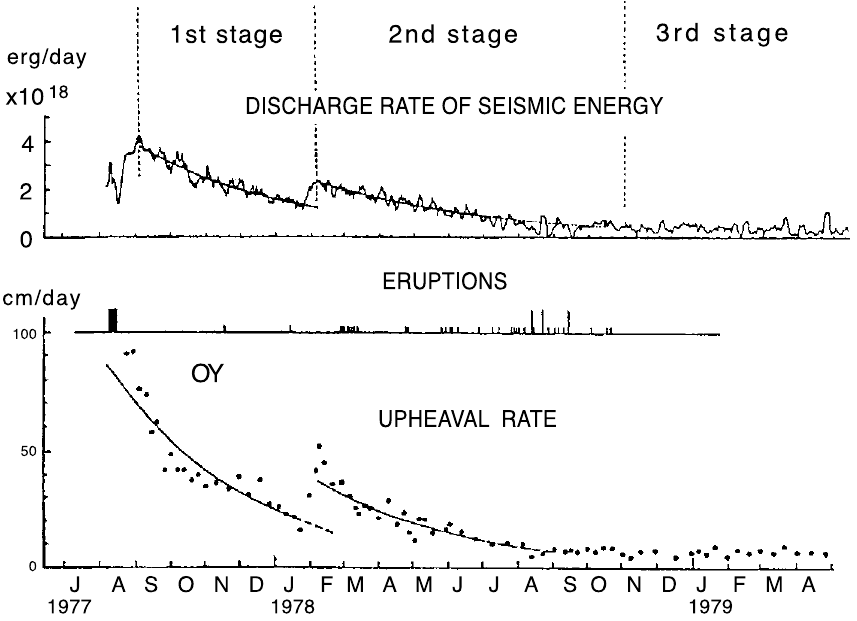
Fig. 4. Seismicity and deformation in the 1977 eruption of Usu volcano, Hokkaido (after Yokoyama et al ., 1981). Daily discharge rate of seismic energy (erg/day) averaged for every 5 days, and daily upheaval rate (cm/day) of the summit dome averaged around observation periods. Eruption magnitudes are shown in arbitrary